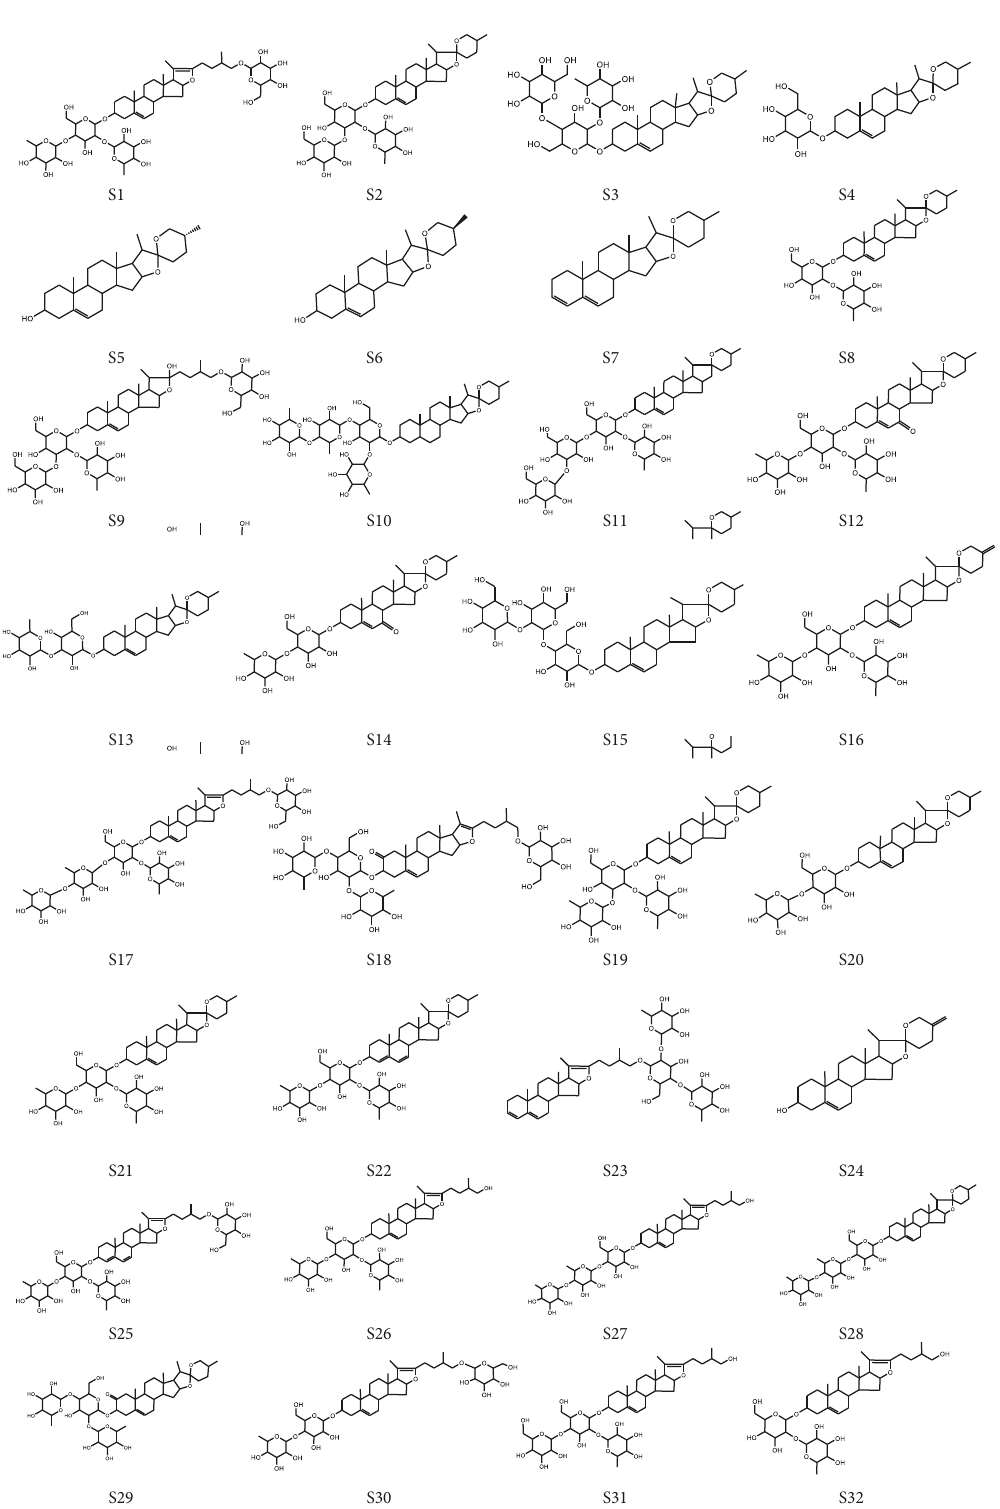
Figure 4: Structural formula of 32